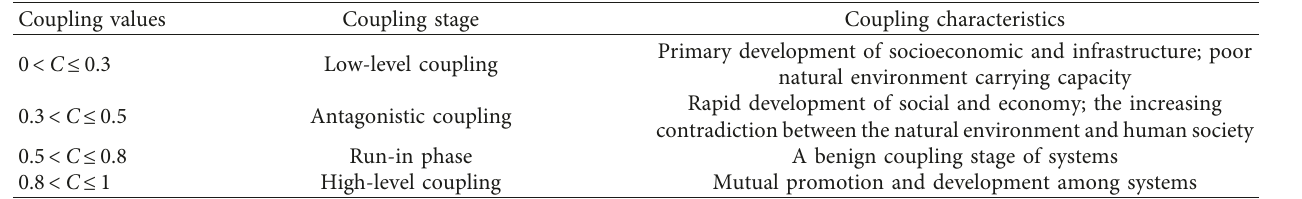
Table 3: Coupling degree classification and coupling level of the human settlements system. Coupling values Coupling stage